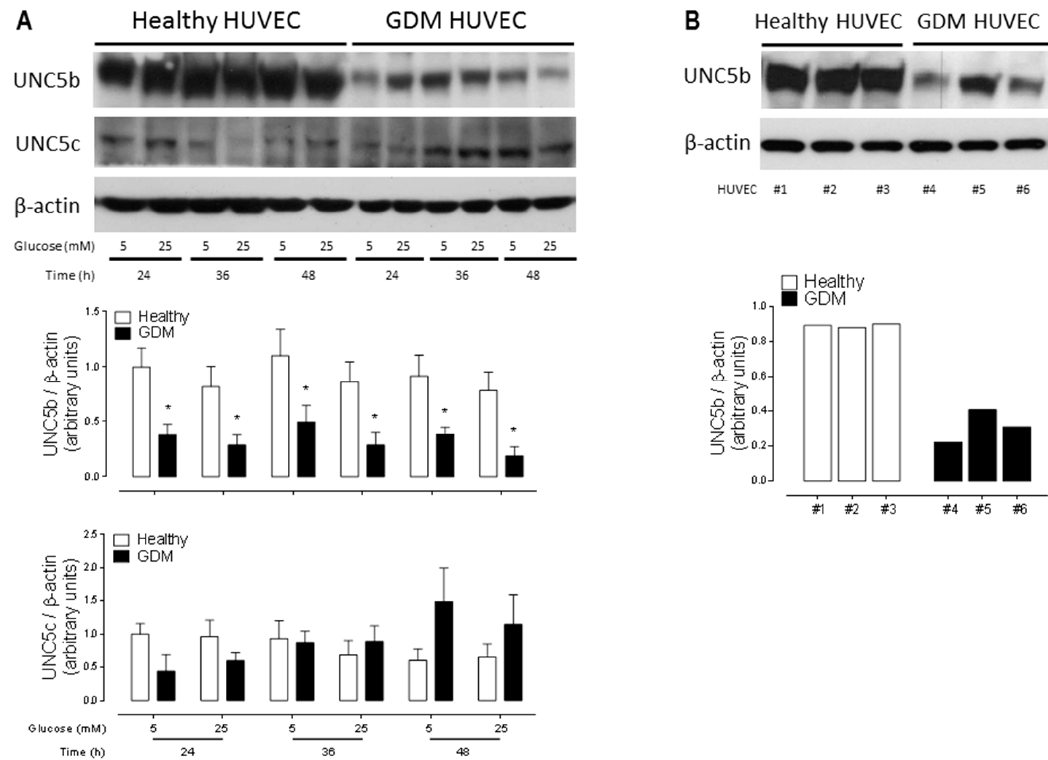
Figure 3. The classical anti-angiogenic Netrin-1 receptor UNC5b is decreased in GDM HUVEC. ( A ) Upper panel shows a representative Western blot for UNC5b and UNC5c protein expression levels in healthy and GDM HUVEC cell lysates. β -actin was used as internal loading control. D -glucose concentration and time points as indicated. Graphs below show quantified results corresponding to the mean ± S.E.M. (healthy n = 3, GDM n = 3). * p < 0.05 vs. healthy. ( B ) Different HUVEC from fresh umbilical cords randomly selected are indicated as #1-6. Western Blot revealing UNC5b protein expression levels in primary cell cultures (0–1 passages) of |healthy and GDM HUVEC. β -actin was used as internal loading control. Graph below shows receptor expression per replicate, labelled #1, #2, #3 for healthy and #4, #5, #6 for GDM HUVEC.